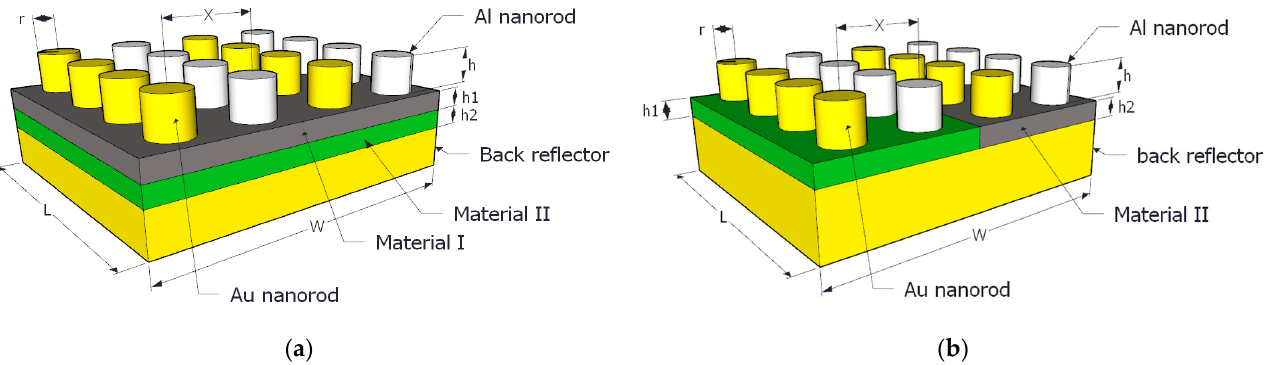
Figure 5. Modified MMA substrate with multi-dielectric layers substrate: ( a ) Two substrates on top of each other; ( b ) two side-by-side substrates.